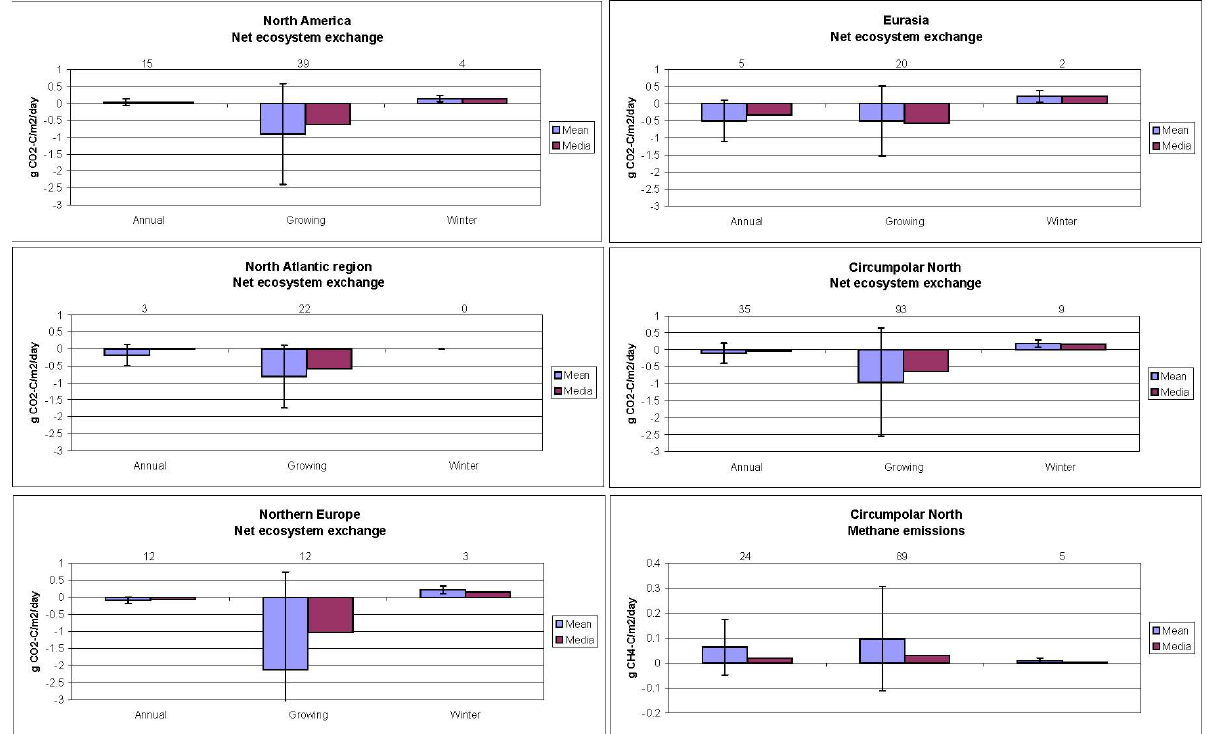
Fig. 2. A summary of the data presented in Supplement 1; the summary includes observations prior to 1990. The synthesis of observed NEE for different geographical regions is shown in the first five panels. The mean (gCm − 2 day − 1 ) +/ − standard deviation and the median are shown for summer, winter, and annual analyses. The number of studies used from Supplement 1 to estimate each mean/median is shown above the bars. Methane emissions for the circumpolar North are shown in the sixth panel in a similar